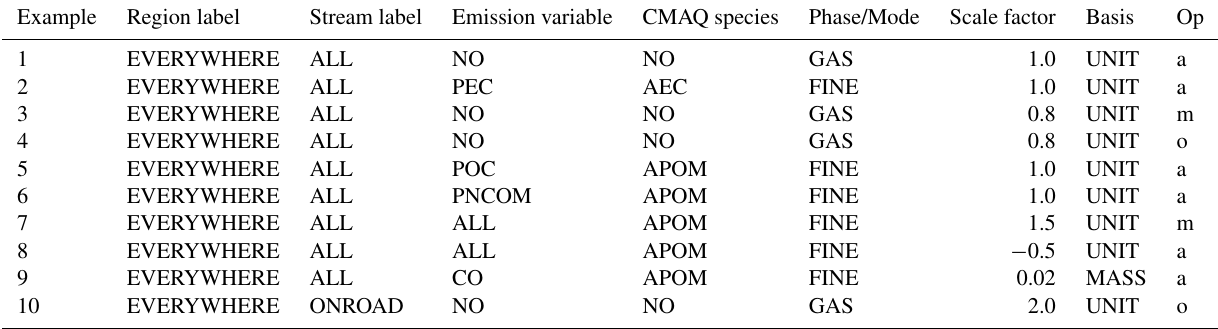
Table 2. Examples of basic scaling rules in the Emissions Scaling component. Example